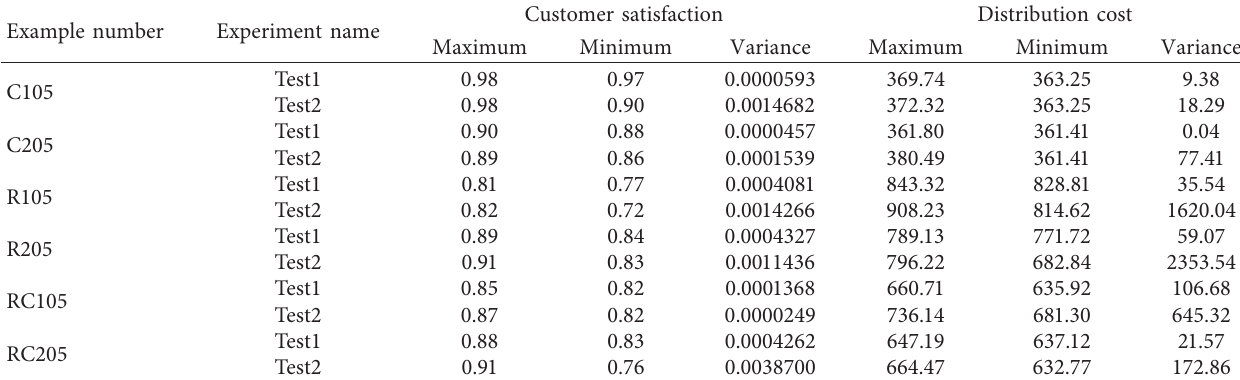
Table 2: Statistics of calculation results.